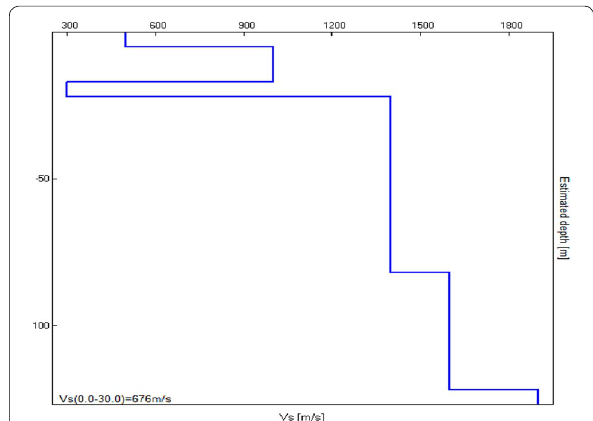
Fig. 6 Shear wave velocity profile at Santura Devi temple area, Mus- soorie